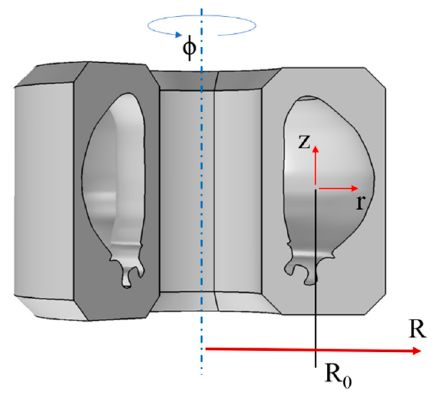
Figure 1. Geometry schematics of the numerical simulation.